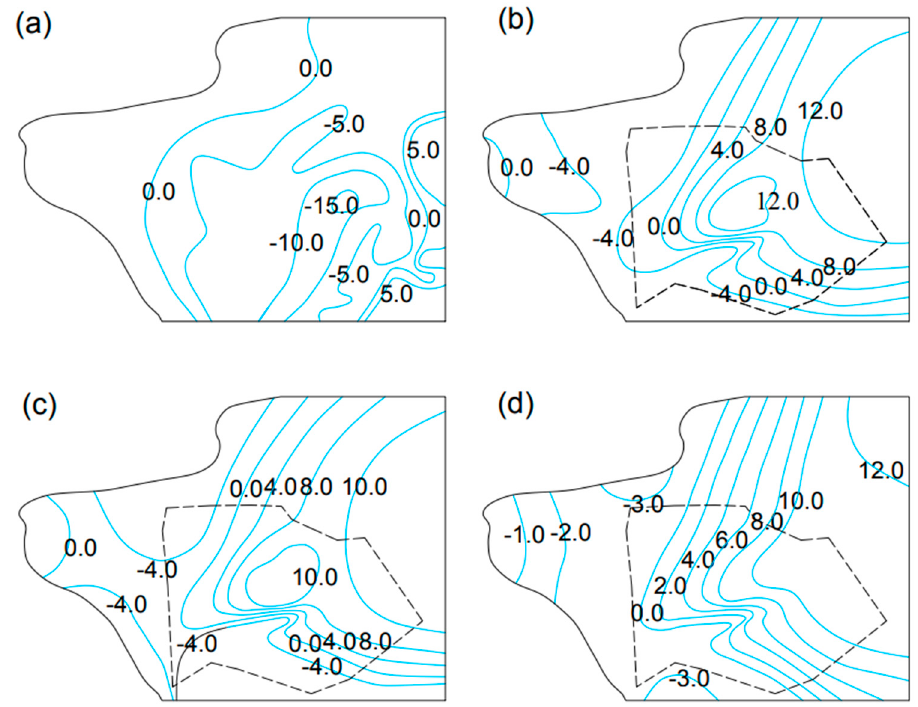
Figure 5. Groundwater flow field in ( a ) 1994 / 06 / 01 before reservoir construction; ( b ) 2004 / 06 / 01 after reservoir construction; ( c ) 2009 / 06 / 01 after reservoir construction; ( d ) 2016 / 06 / 01 after reservoir construction. (unit: m).